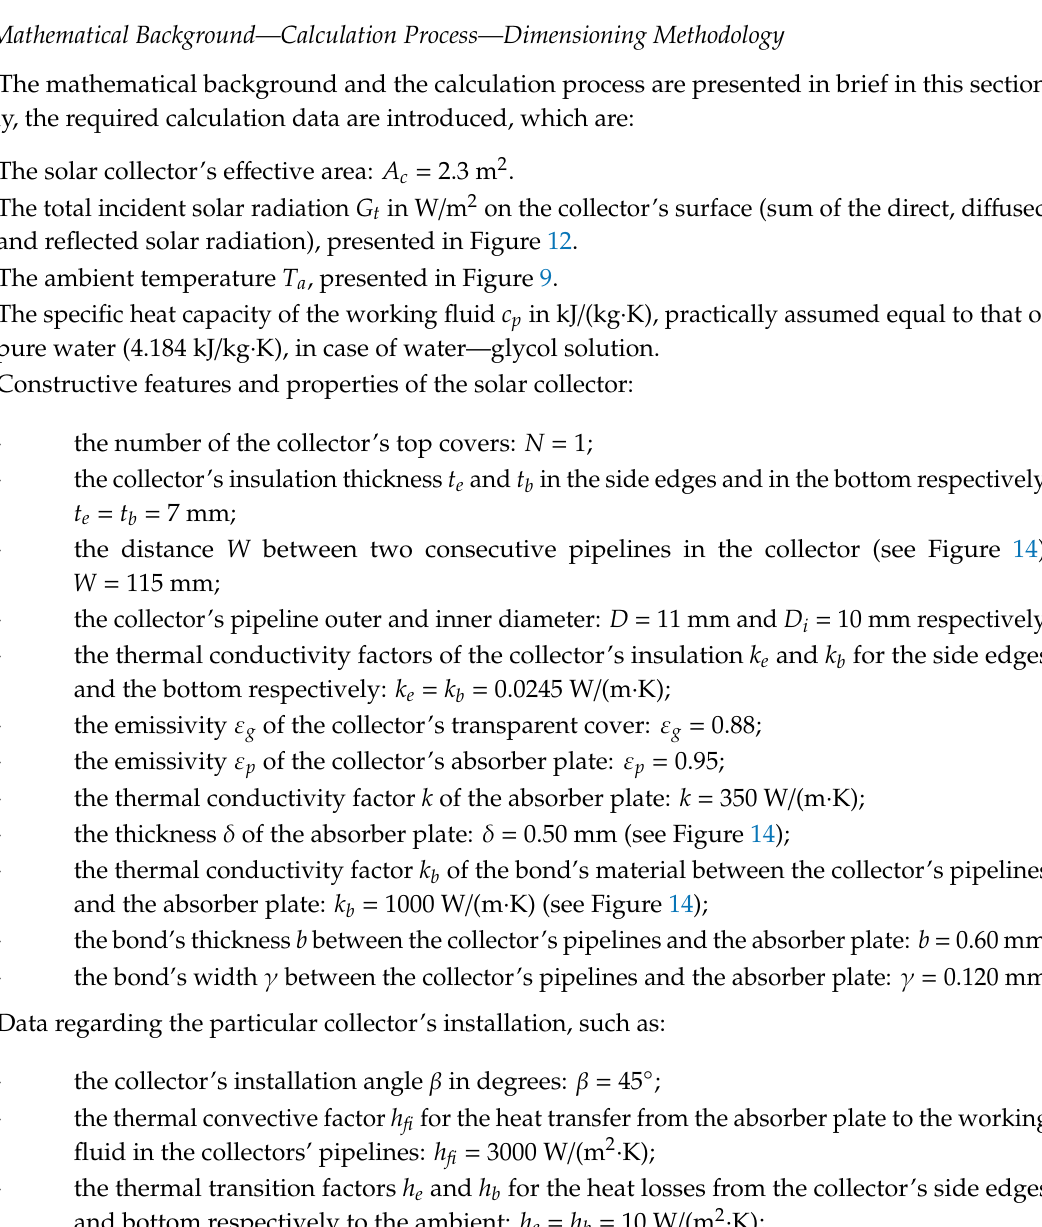
Figure 13. Essential installation and siting features of the solar collectors’